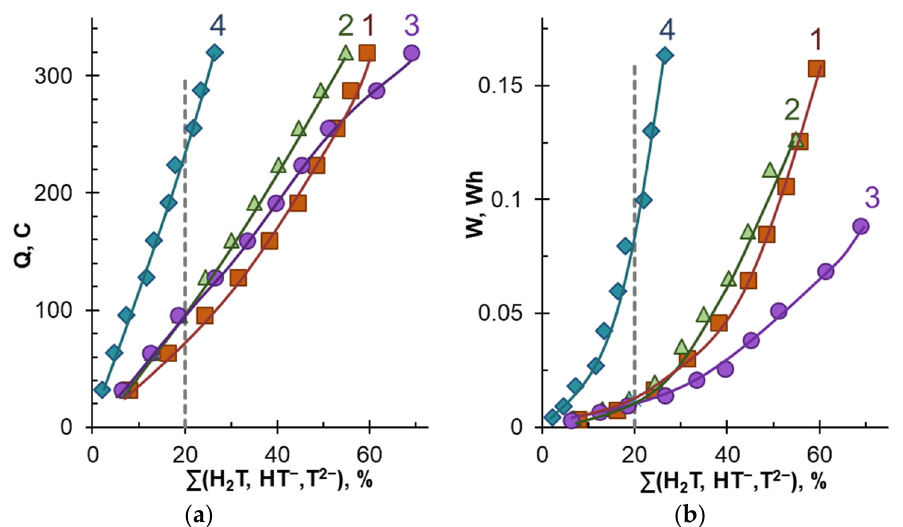
Figure 5. The number of electrical charges transported ( a ) and energy consumption ( b ) vs. the degree of tartrates removal from model solutions. The numbers near the curves correspond to the designations in Table 2. The dotted line corresponds to the degree of recovery, which is considered sufficient to stabilize red wines [47]. The solid lines should guide the eye. Table 3. Some characteristics of ED processing of the studied model solutions.